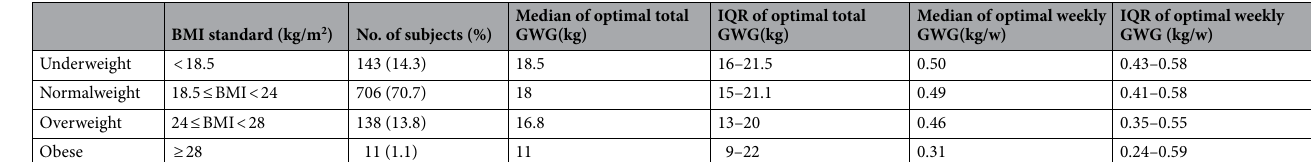
Table 2. This distribution of optimal total GWG and weekly GWG in the optimal outcome subgroup. GWG gestational weight gain, BMI body mass index, IQR interquartile